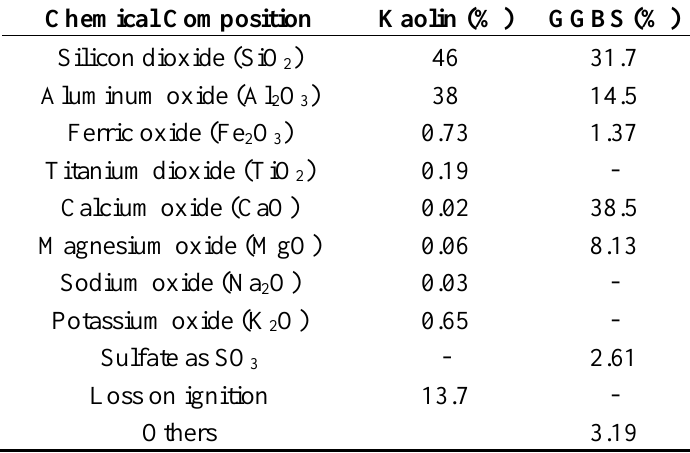
Figure 1. Materials used in this research: ( a ) Paraffin; ( b ) Kaolin; ( c ) ground granulated blast-furnace slag (GGBS). Table 1. Chemical composition of building